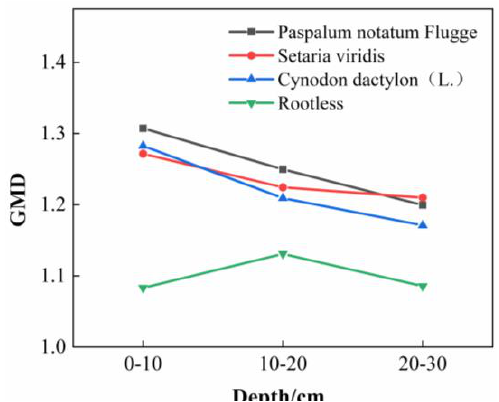
Figure 12. The effect of depth on GMD.